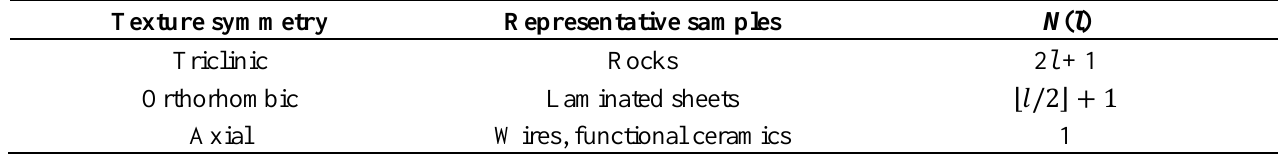
Table 1. Range of summation indexes N ( l ) = max v in average